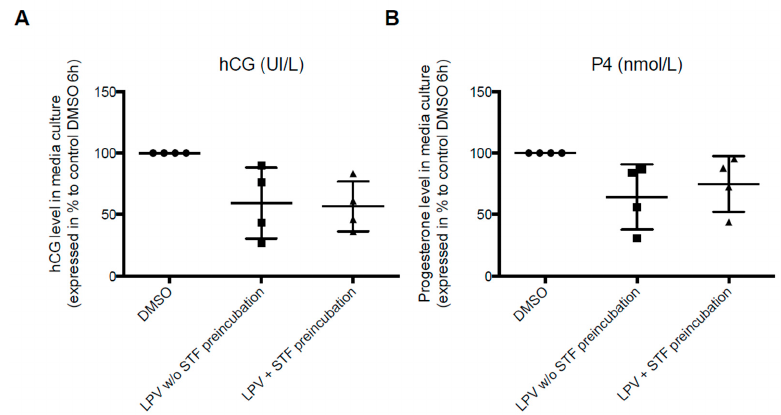
Figure 14. Inhibition of IRE1 α pathway does not prevent the inhibitory effect of LPV on hCG and P4 secretions. VCT cells isolated from human term placenta were cultured for 72 h. Cells were further incubated for 2 h with STF (100 µM) (LPV + STF preincubation) or DMSO control (LPV without ( w/o ) STF preincubation) before incubation for 4 h with LPV (10 µM). hCG ( A ) and P4 ( B ) levels were measured in supernatant. The results are presented as the mean +/ − SD from four independent experiments. Int. J. Mol. Sci. 2021 , 22 , x FOR PEER REVIEW In addition, this pre-incubation did not modify the expression of either P450SCC or HSD3B1 (Figure 15) at both mRNA and protein levels.